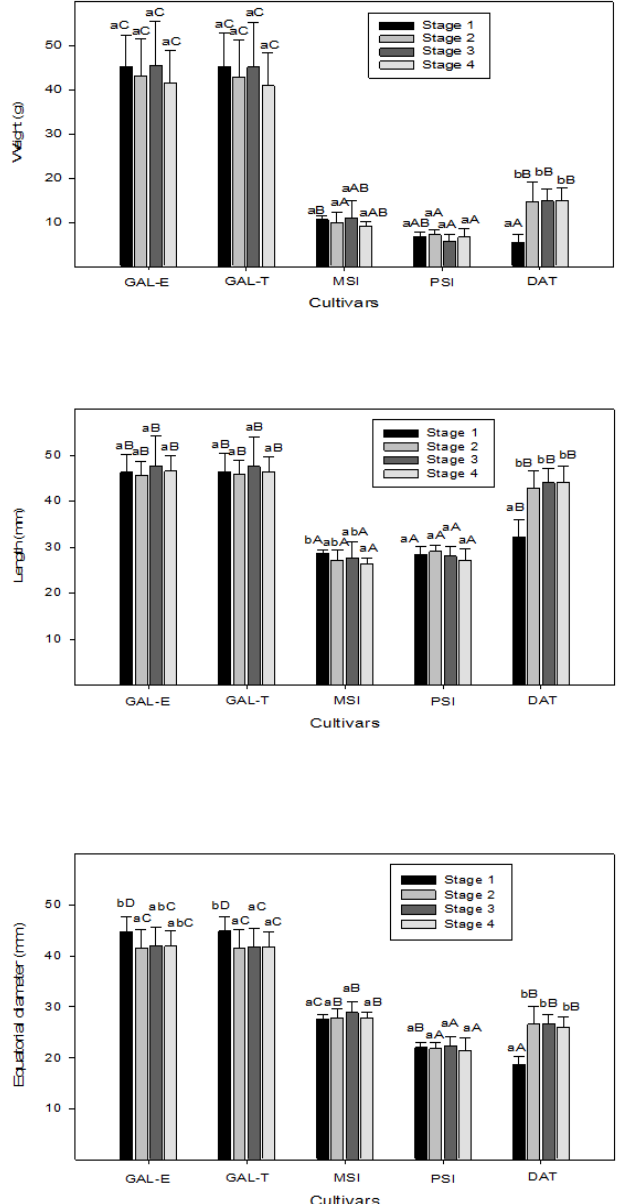
Figure 2. Weight, length, and equatorial diameter of jujube fruits as affected by cultivar and stage of development. The same letters (a, b, c) indicate non significance ( p < 0.05) at the different stages. The same letters (A, B, C…) indicate significance ( p < 0.05) in the different cultivars.